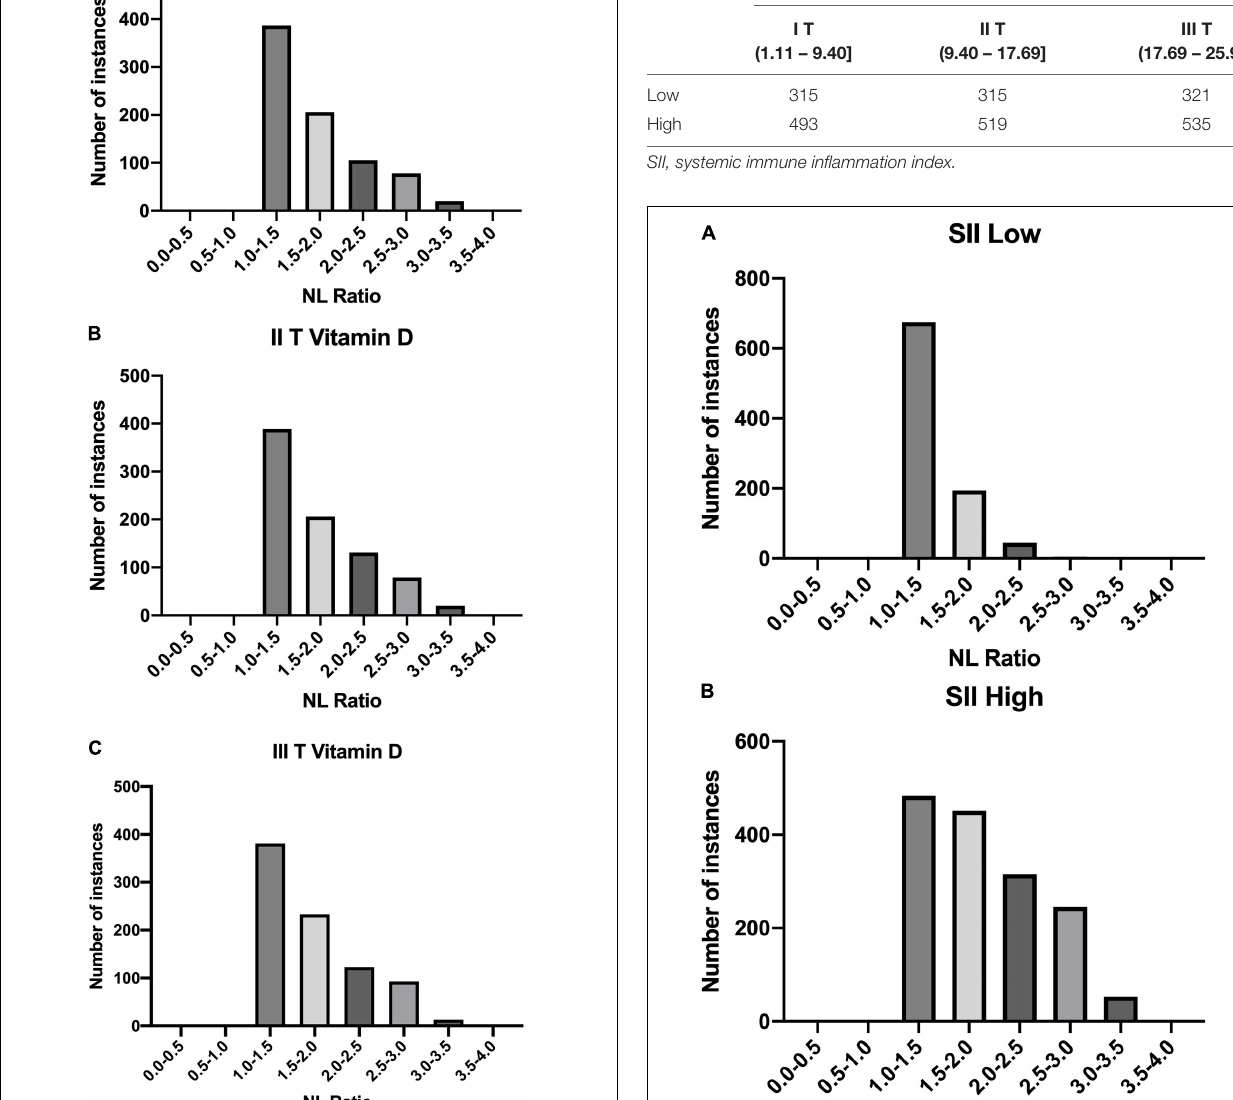
each of the tertiles of vitamin D was correlated with SII high value (SII High: ≥ 410). In each of the tertiles of vitamin D, we